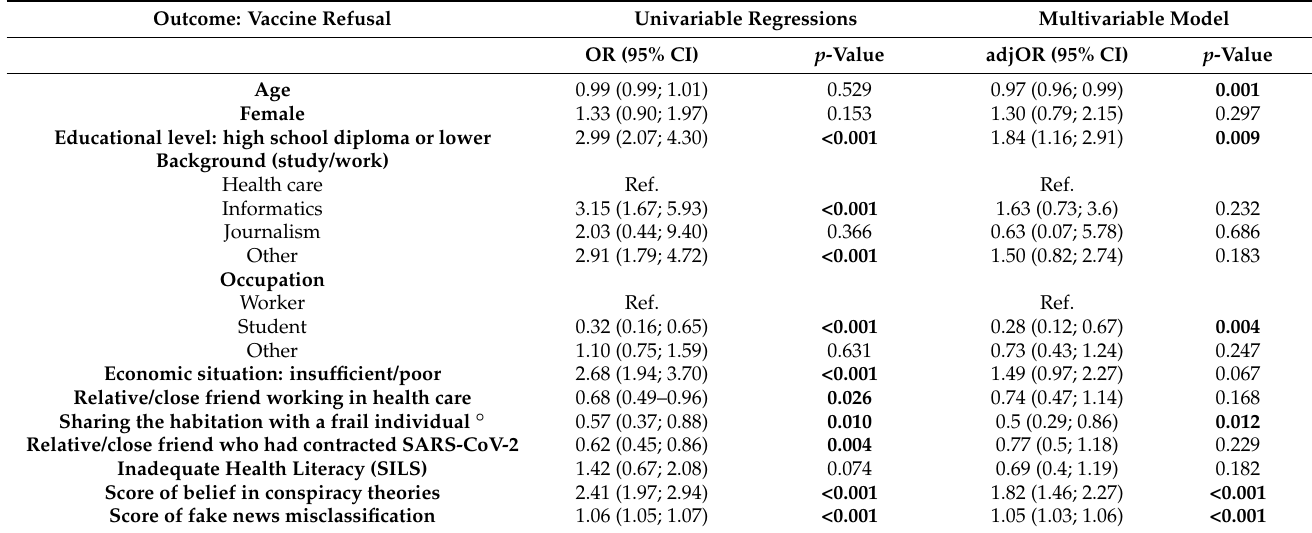
Table 3. Univariable and multivariable logistic regressions with vaccine refusal as outcome.